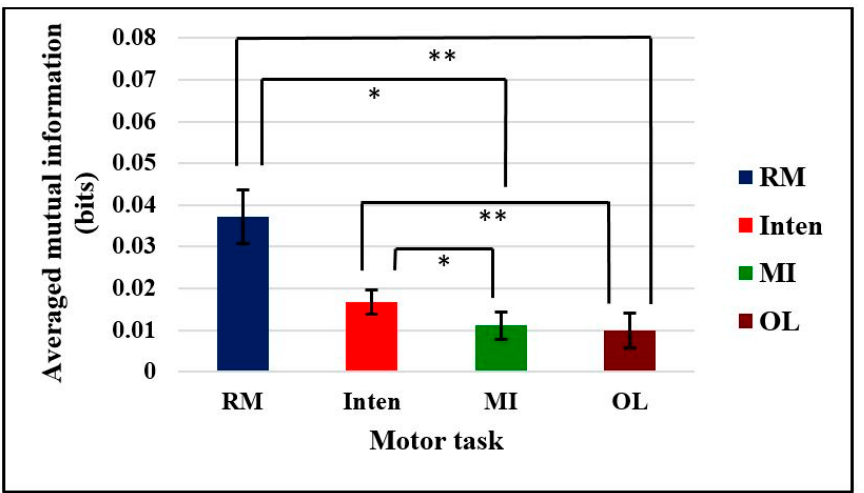
Figure 10. Averaged mutual information comparison across all motor tasks. The asymptotic signif- icance (two-sided tests) is displayed with a standard error bar. The significant differences in each motor task were * p < 0.05 ** p < 0.01.